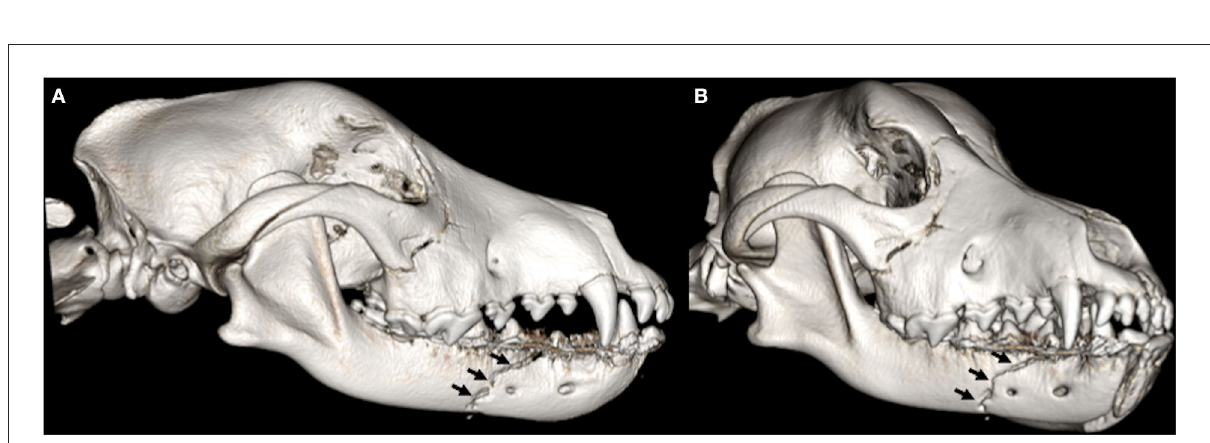
FIGURE6 1-month follow-up 3D-rendered right lateral (A) and oblique (B) CBCT images of the skull of the same dog as in Figure 5. An interdental wire and composite splint were placed to reduce the fracture fragments. There is a persistent fracture gap with no evidence of bridging callus formation suggestive of a non-union.